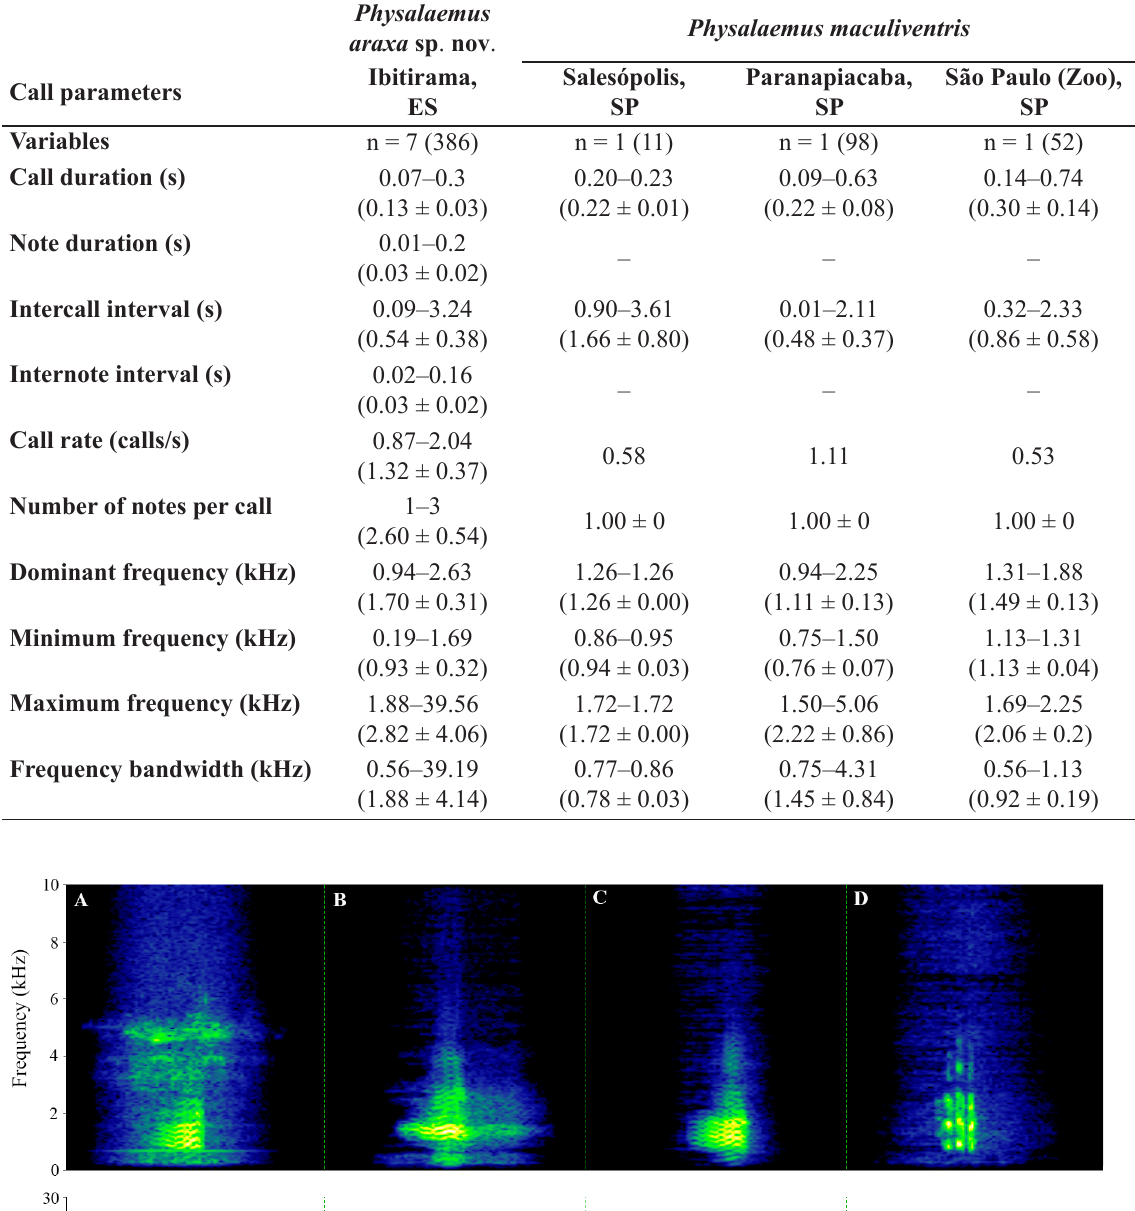
Table 2. Temporal and spectral parameters of the advertisement call of Physalaemus araxa sp. nov. and P. maculiventris (Lutz, 1925). Values are presented as a range (average ± SD); n = number of males (number of calls analyzed).